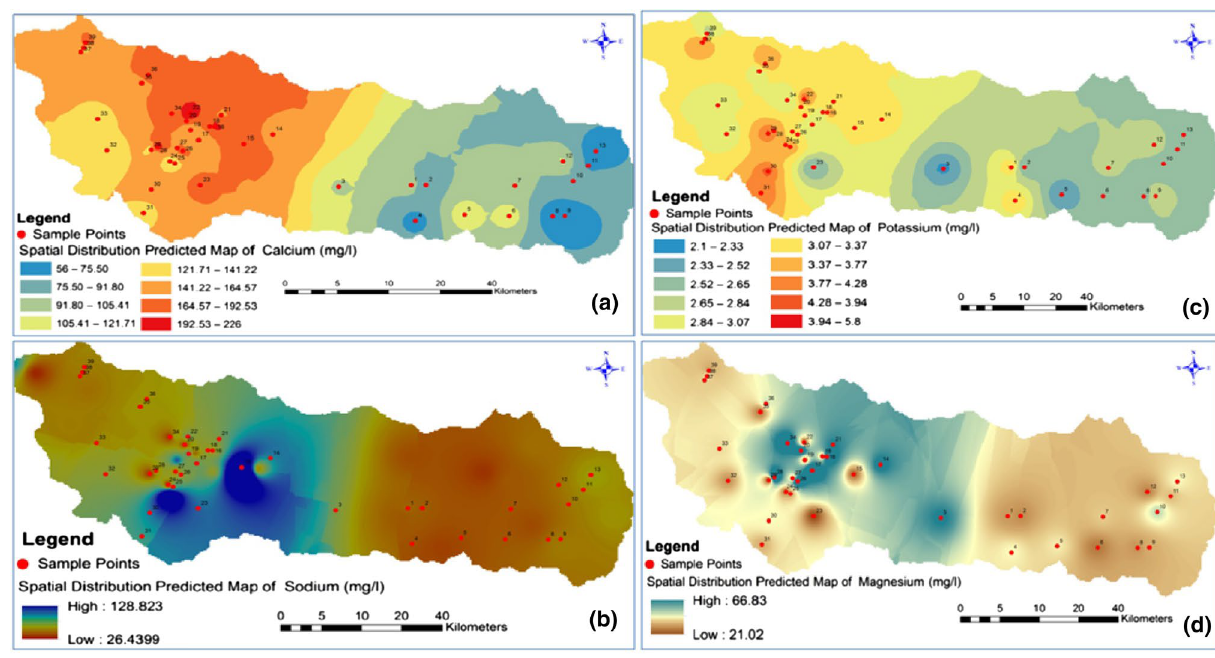
Fig. 3 Spatial distribution map of the major cation